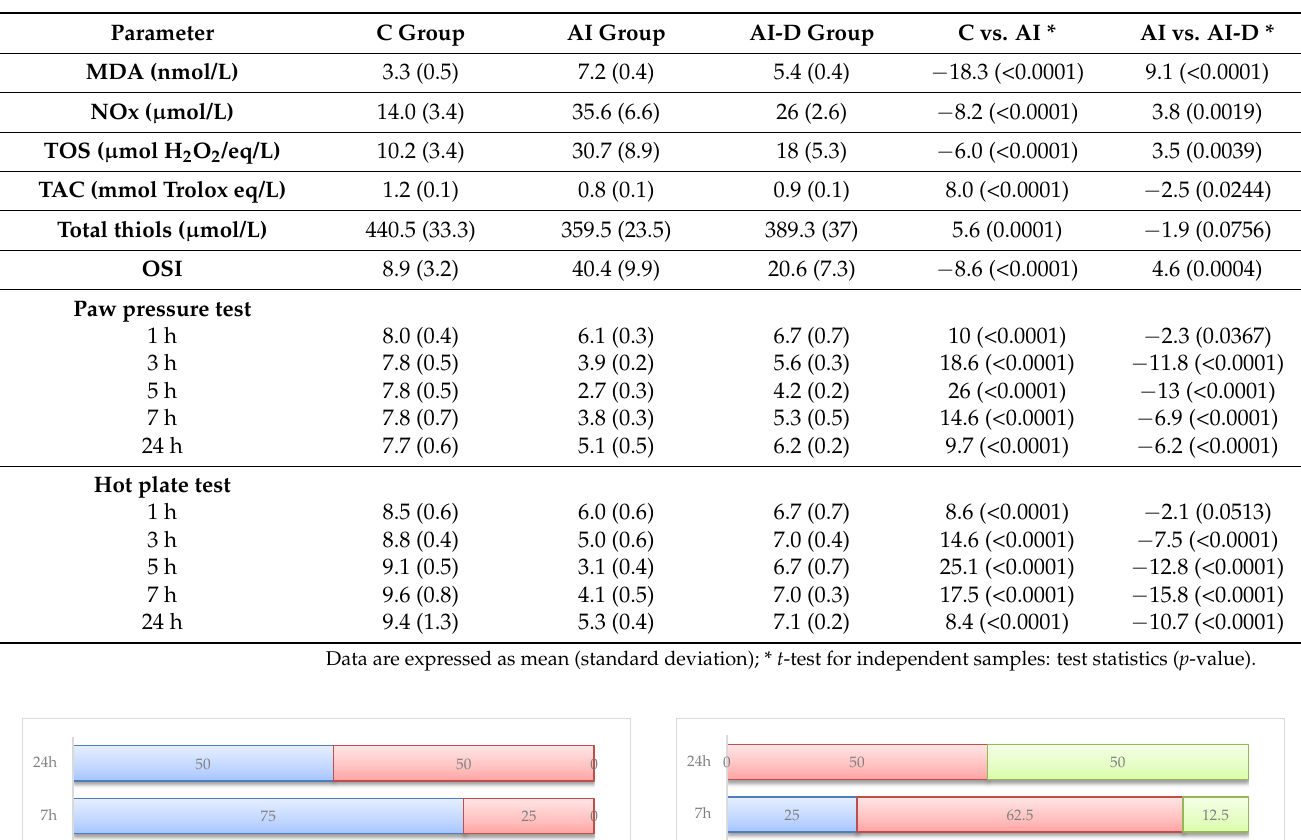
Table 5. Serum levels of evaluated biomarkers, paw pressure and hot plate tests for the control (C), acute inflammation (AI) and acute inflammation treated with diclofenac (AI-D) groups.